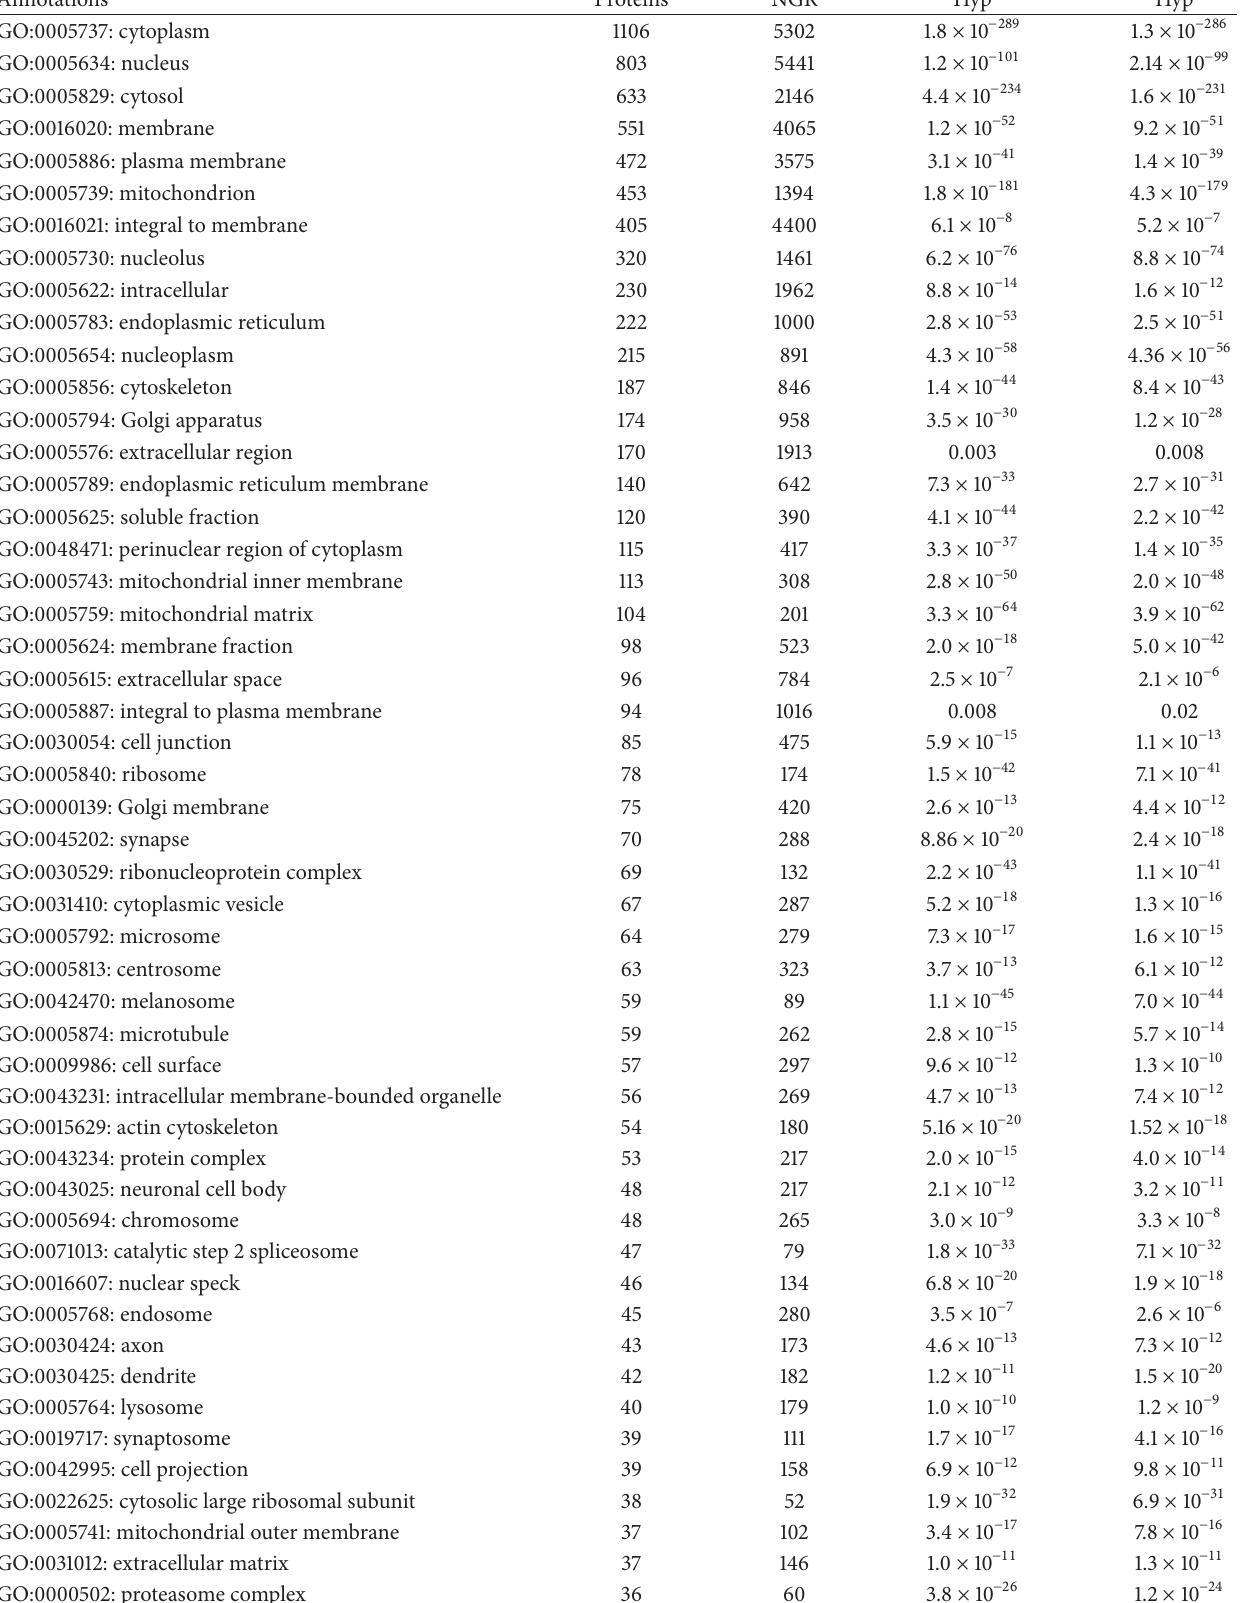
Table 1: Gene Ontology cellular compartment